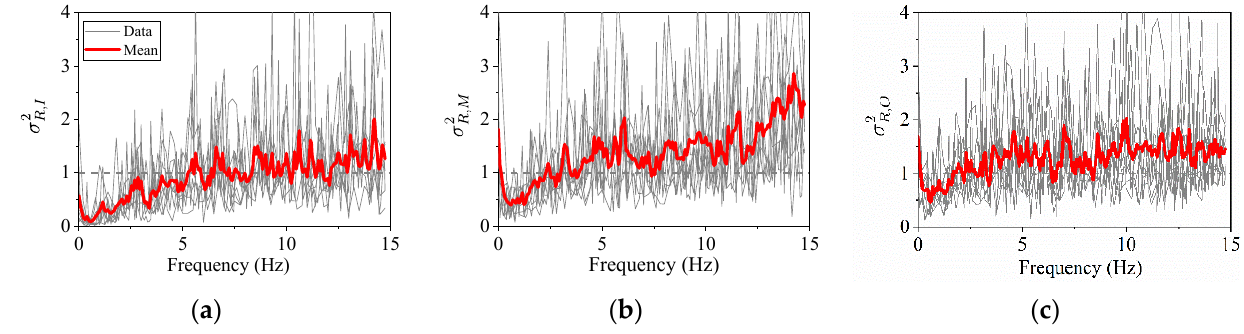
R in different loops: ( a ) inner loop, ( b ) middle loop, and ( c ) outer Figure 7. Loop variance of Figure 7. Loop variance of R ei , rj in different loops: ( a ) inner loop, ( b ) middle loop, and ( c ) outer loop. , ei rj loop.